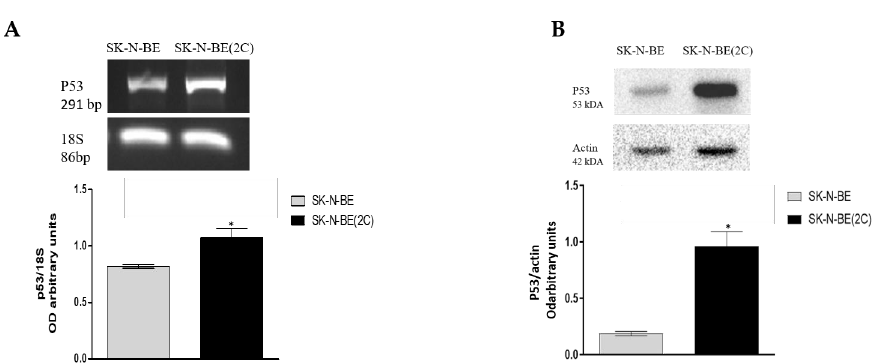
Figure 4. Representative RT-PCR and Western blot showing the p53 transcript ( A ) and protein ( B )